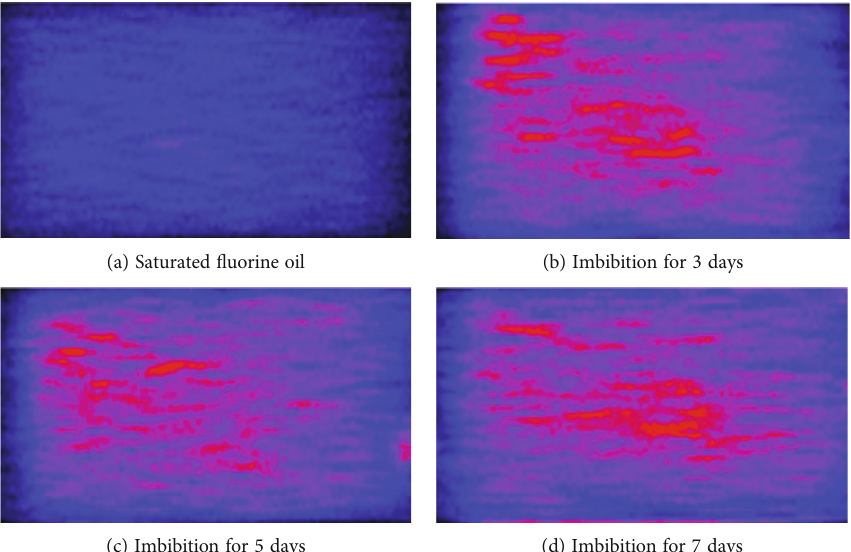
Figure 4: Pseudo-color image of core 1 (red is the water phase signal).